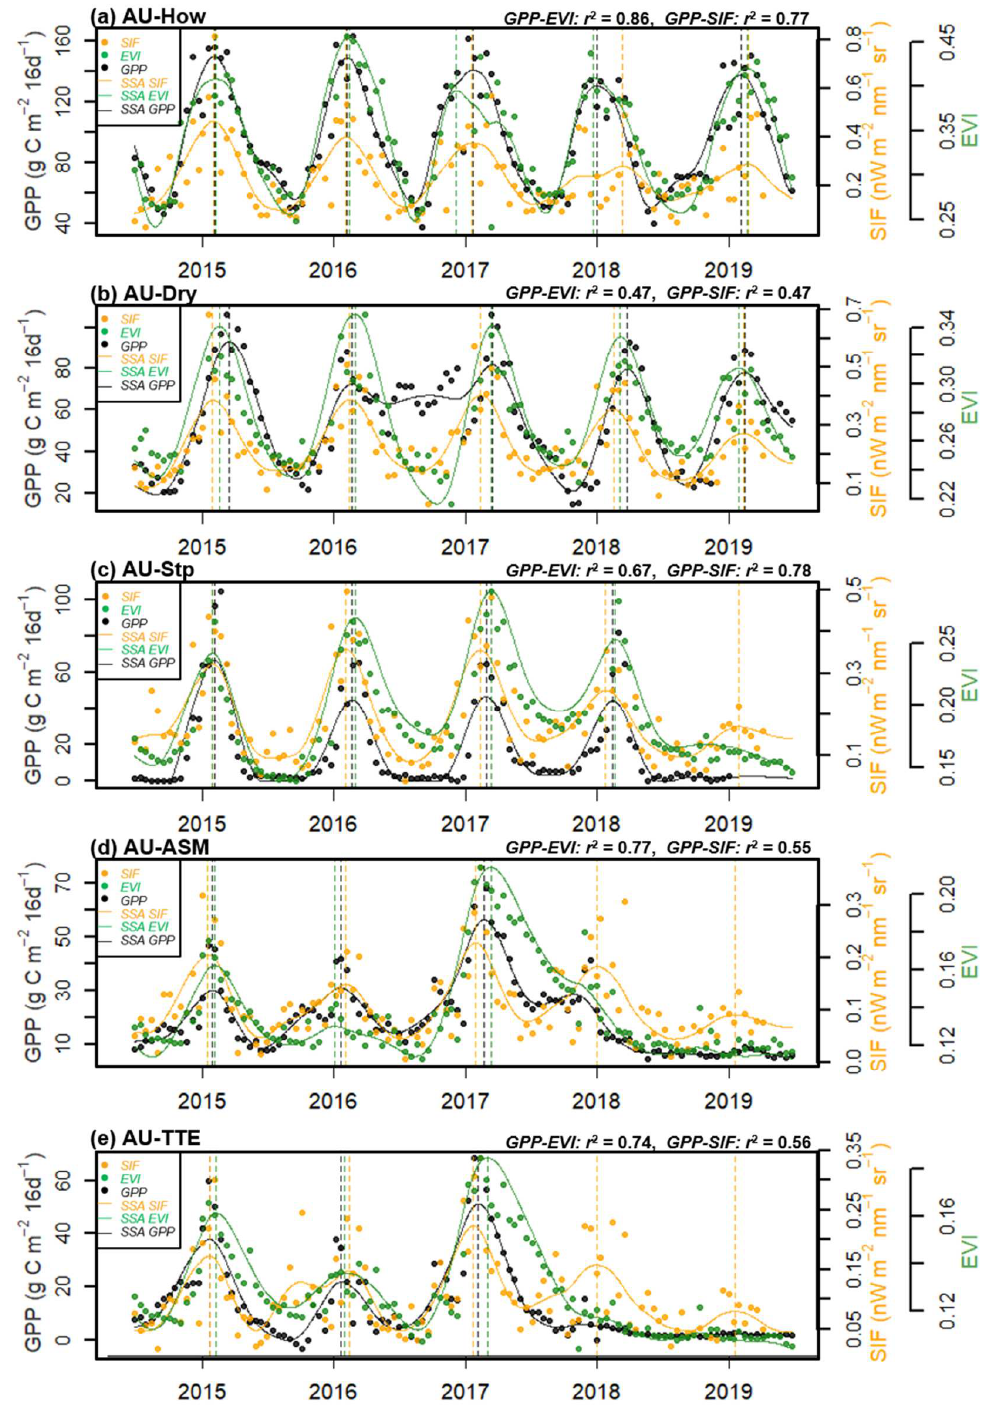
Figure 3. Time series of SSA-reconstructed tower-based GPP, GOME-2 SIF, MODIS EVI over ( a ) AU-How, ( b ) AU-Dry, ( c ) AU-Stp, ( d ) AU-ASM, and ( e ) AU-TTE. R-squared ( r 2 ) refers to the relationship between GPP and EVI (green) and GPP and SIF (orange), respectively. Vertical dashed lines refer to the peak of the growing season in each hydrological year.